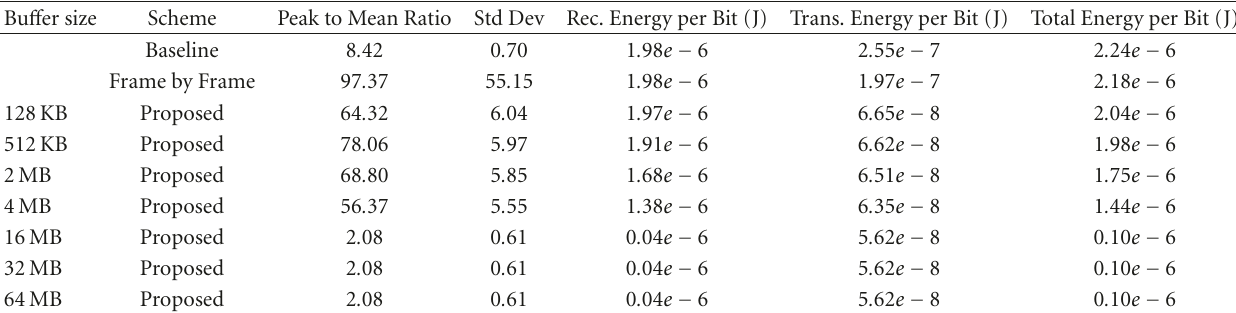
Table 4: Performance comparison for di ff erent bu ff er sizes for Stream 1 ( d = 15 m).